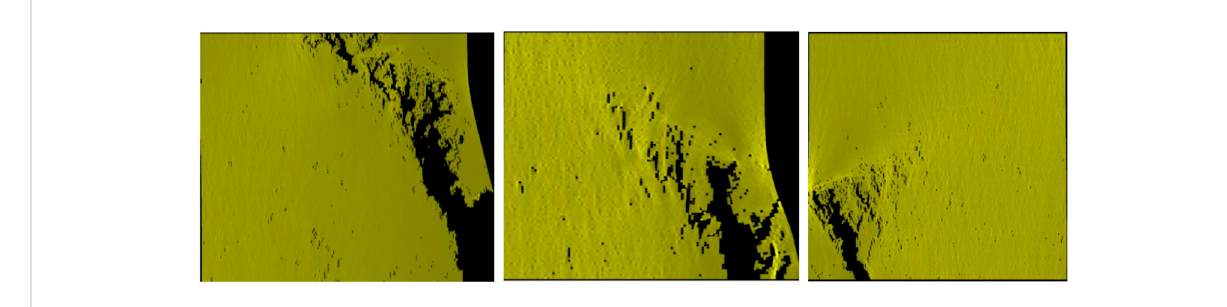
FIGURE 3 Failure modes of water pressure samples with the same strength and different lower